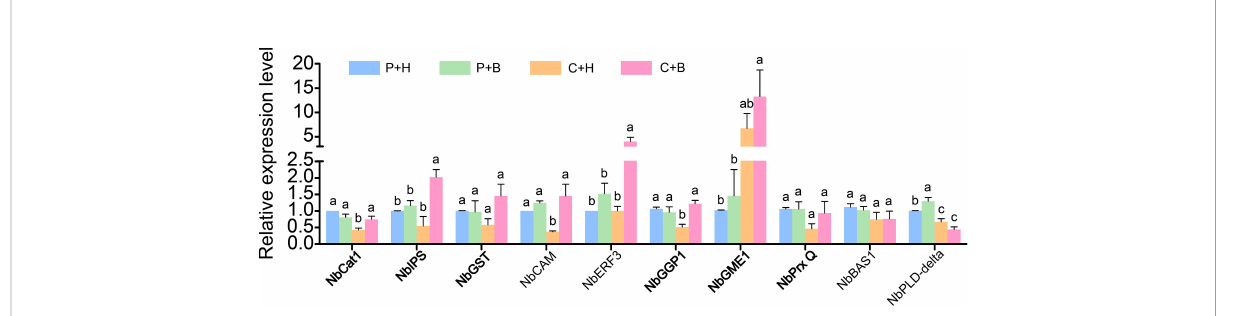
FIGURE 6 The expression levels of ten ROS-related genes were determined by RT-qPCR. Lowercase letters indicate statistical difference between treatments. The statistical signi fi cances were determined using one-way analysis of variance followed by Duncan ’ s multiple comparison test ( P